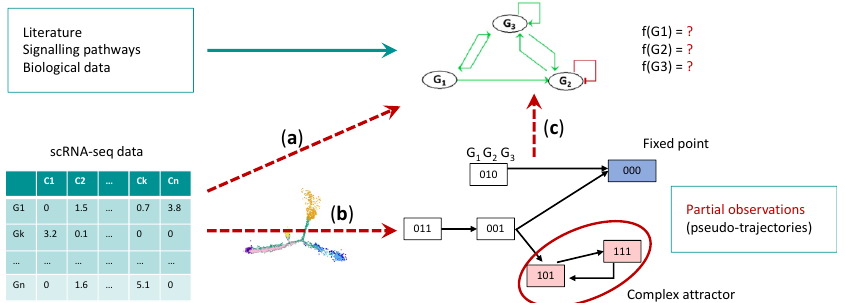
Figure 4. Boolean Network inference . Workflow of Boolean network inference from scRNA-seq data. ( a ) scRNA-seq data can be used to infer transcriptional interactions between TFs and complement influence graph constructed from prior knowledge of the searched BN. ( b ) The pseudo trajectories issued from the scRNA-seq data, can be discretized and translated in discrete observations of the searched BN. ( c ) Given these inputs, constraint programming can be used to infer the logical rules of the BN.